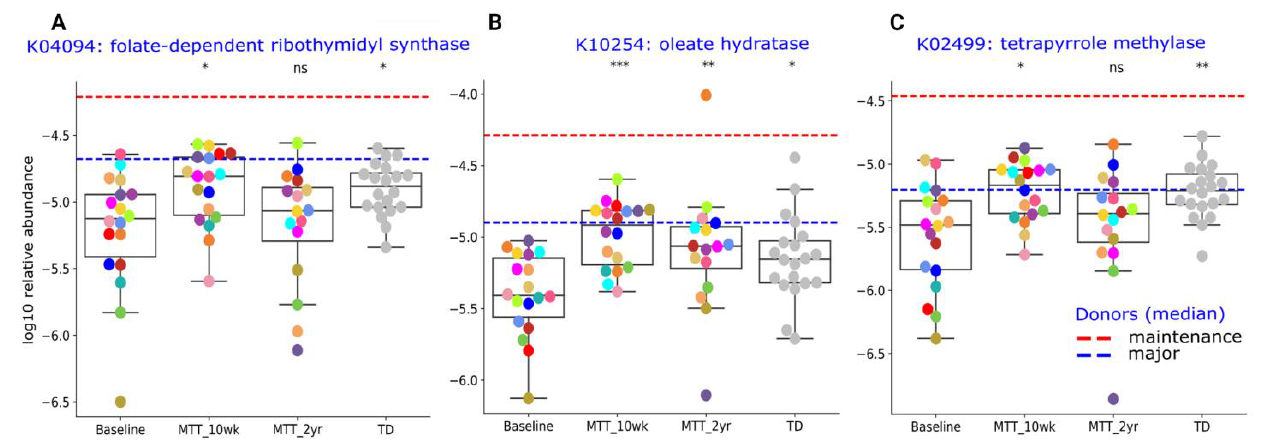
Figure 6. Univariate comparison of the relative abundance (after log 10 transformation) of gut micro- biome genes/KOs that changed significantly after MTT in ASD and became more similar to gene profiles in TD. ( A ) K04094: folate-dependent ribothymidyl synthase, ( B ) K10254: oleate hydratase, ( C ) K02499: tetrapyrrole methylase. Red-dashed lines represent the mean of maintenance ( n = 2) and blue represent the median of major donors ( n = 5). Colored dots represent ASD individuals and grey-colored dots represent TD. Asterisks represent significant differences between ASD Baseline and the other groups (* single asterisk indicates p < 0.05; ** double asterisks indicate p < 0.01; triple *** asterisks indicate p < 0.001; ns: not significant; all p -values are FDR-corrected). ASD: autism spec- trum disorder; TD: typically developing. 2.5. Abundance of Genes Encoding for Oxidative Stress Protection and Sulfur Metabolism Changed after MTT Functional gene analyses of the gut microbiome also revealed that MTT might support the microbial ecosystem by increasing the abundance of microbes that can detoxify oxy- gen, and microbes with enzymes that protect against oxidative stress. As seen in Figures 5 and 7A, the relative abundance of the gene that encodes for K05919 ( dfx gene , SOR): superoxide reductase was significantly lower in ASD at Baseline, and significantly in- creased (adjusted p < 0.05) at MTT-10 wk and -2 yr vs. Baseline, and became more similar to the TD group.